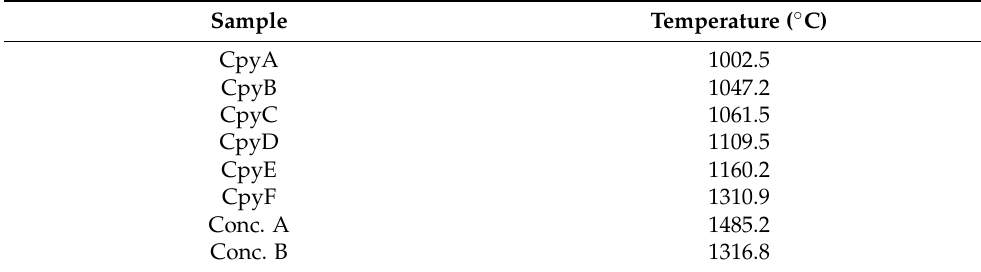
Table 3. Average estimated temperatures of the combustion flames.